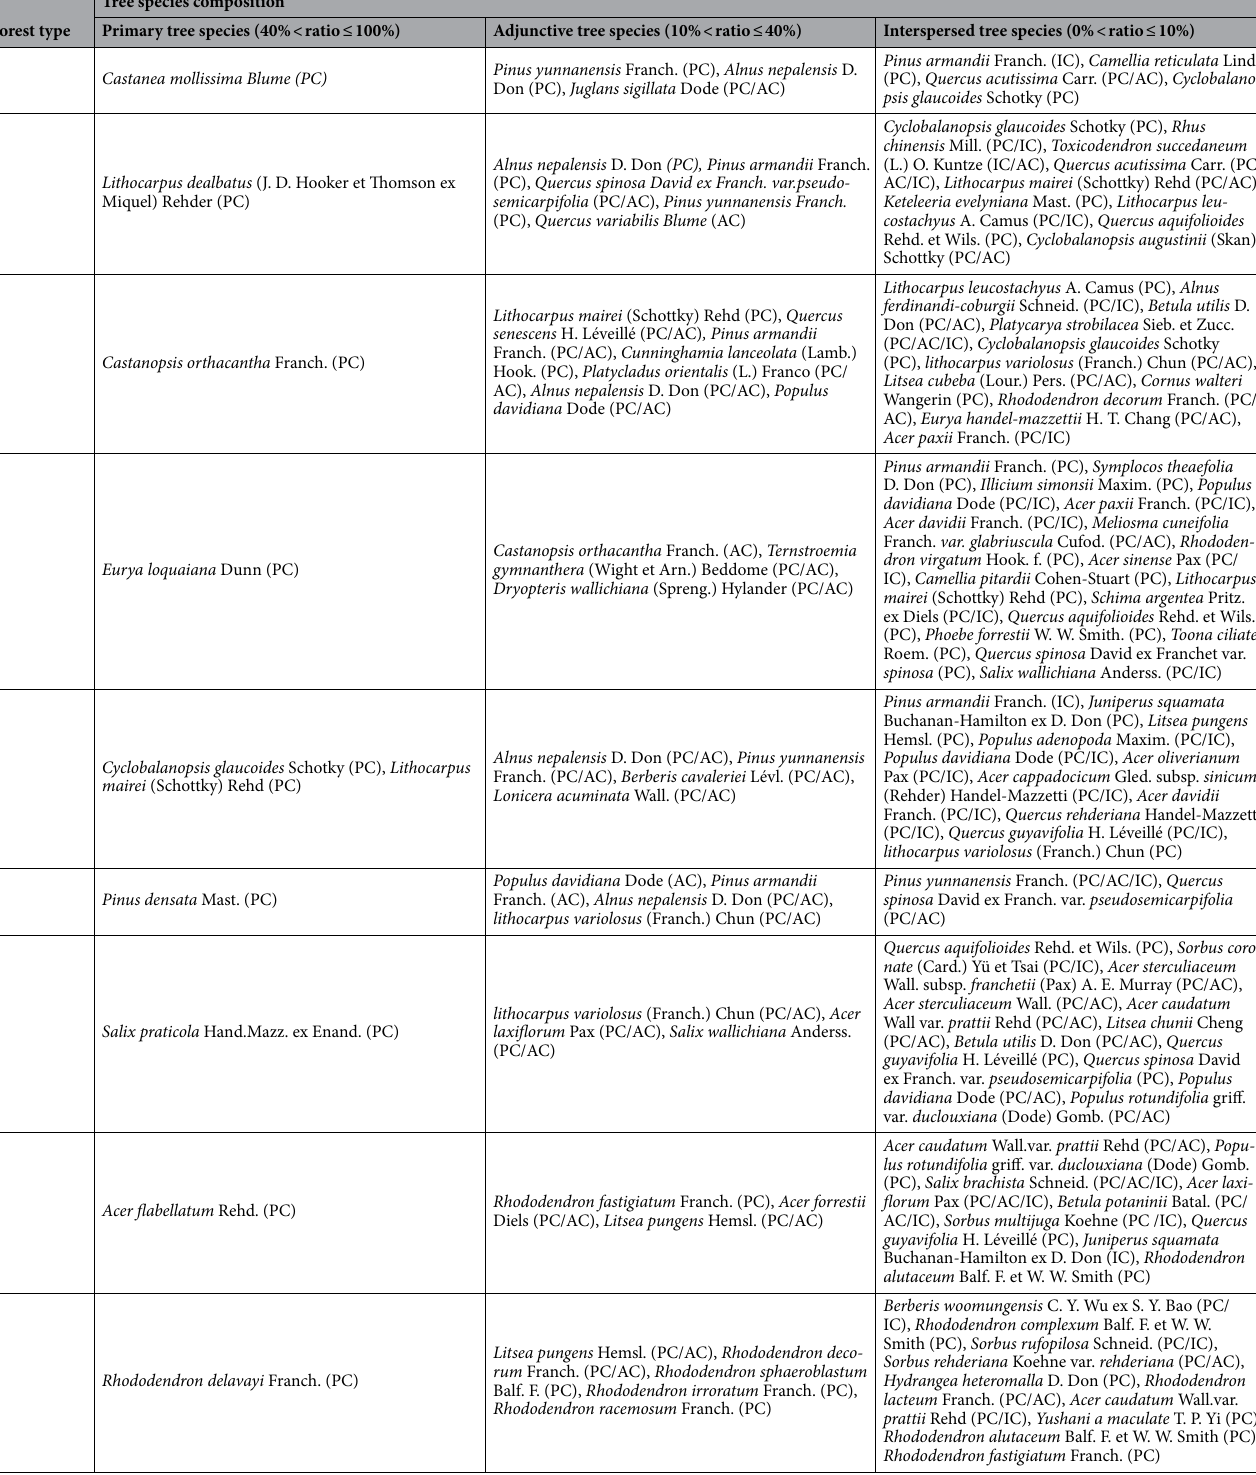
Table 3. The 84 tree species identified were categorized according to their color dominance in the nine slope forests with superior visual aesthetic quality (forest type). PC primary color, AC adjunctive color, IC interspersed